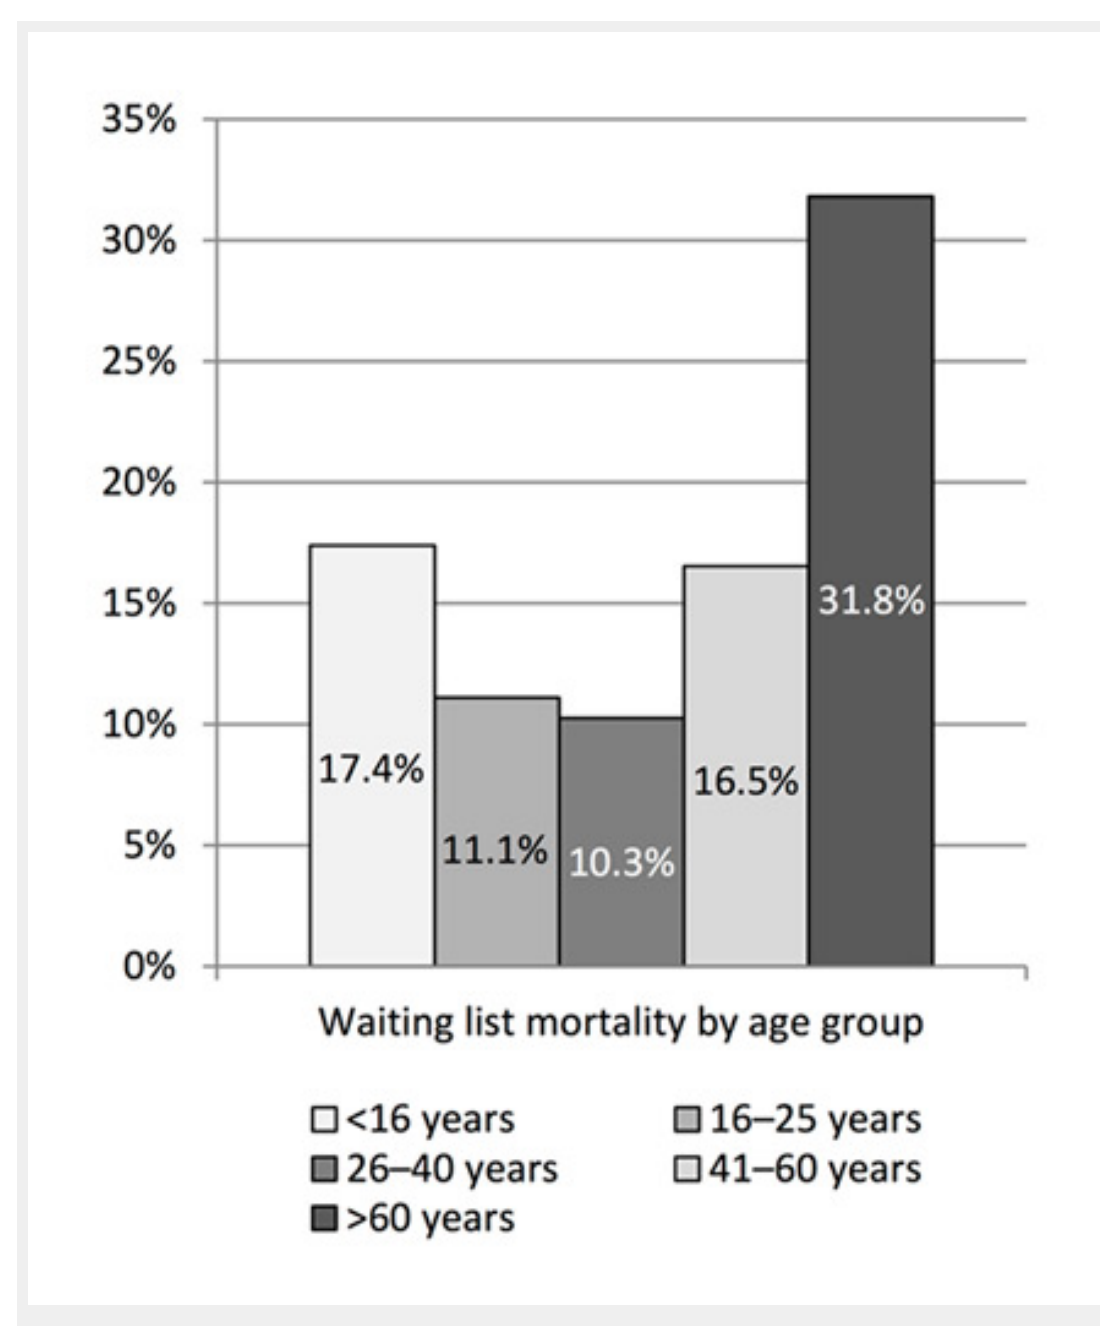
Figure 4 Waiting list mortality by age